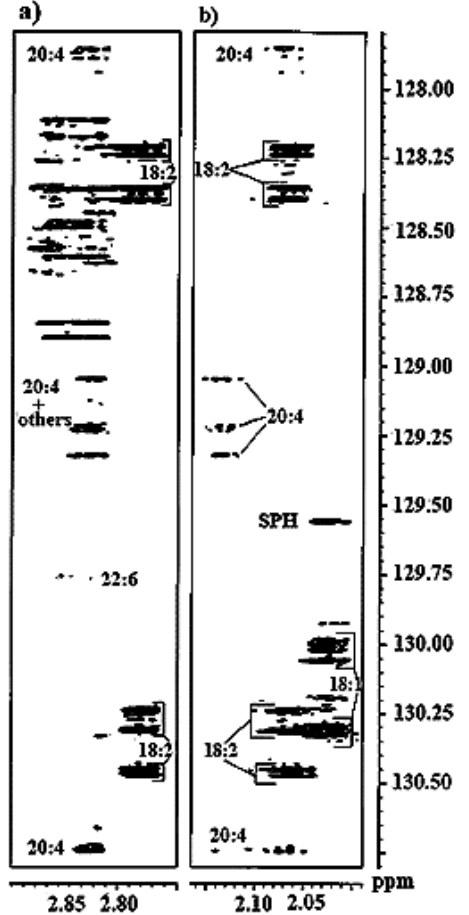
Figure 40. Semi-selective 800 MHz HSQC-TOCSY spectrum of the double bond region of blood plasma lipids. ( a ) Correlations to the allylic Δ–CH 2 –Δ protons (ca. 2.8 ppm) (b); Δ– 1 CH protons (ca . 2.05 ppm). In the Δ–CH 2 –Δ region the 18:2 signals are well separated from the higher polyunsaturated fatty acids, whereas in the Δ–1 region the 18:1 signals are separated from all other signals. The 20:4 fatty acid shows additional well separated signals at 2.13 ppm. Adopted, with permission, from [89]. Copyright 1998, John Wiley & Sons, Ltd.